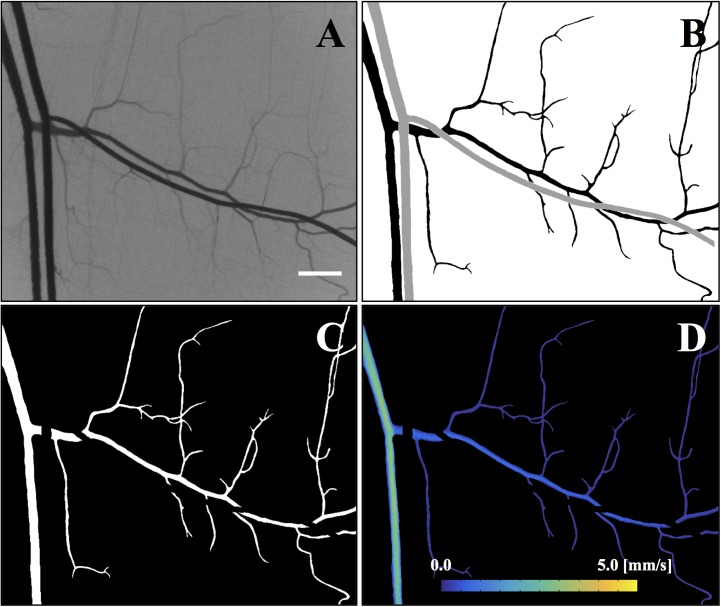
Velocity map of venular network flow.
A: Speckle contrast image obtained at normal arterial pressure (MAP = 100 mmHg). B: Binary image for the vessel mask (Black: venules, Gray: arterioles). C: Venular vessel mask. D: Venular velocity map. Scale bar = 500 μm.